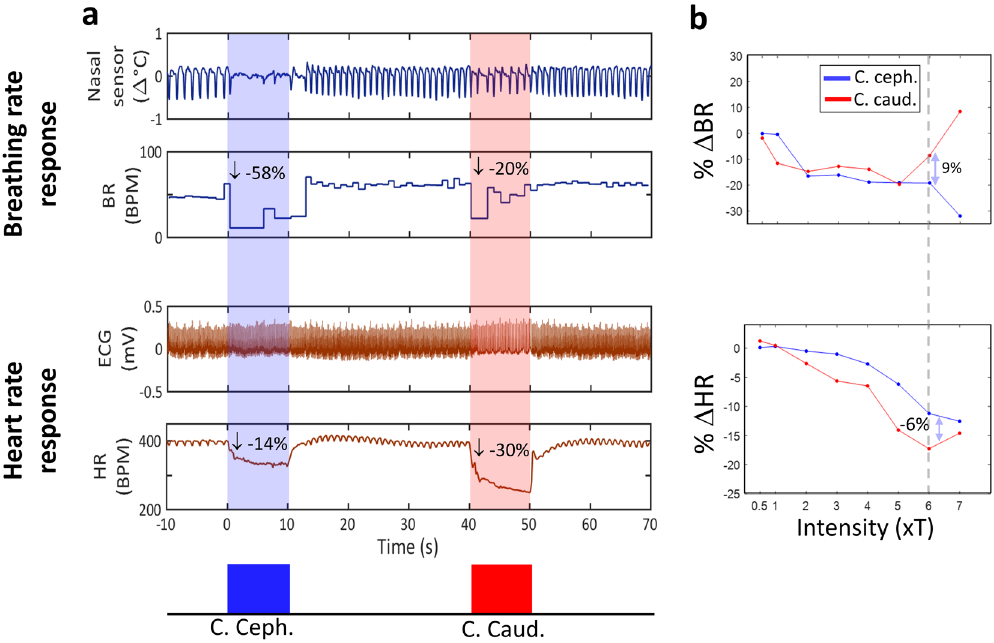
Figure 2. Afferent and efferent physiological responses to VNS of opposite polarities. ( a ) Afferent (breathing rate, BR) and efferent (heart rate, HR) responses to individual VNS trains of stimuli of 2 opposite polarities: cathode cephalad (blue trace), followed by cathode caudad (red trace). Cathode cephalad polarity was associated with a stronger afferent response ( − 58% change in BR and − 14% change in HR), whereas cathode caudad with a stronger efferent response ( − 20% change in BR and − 30% in HR). Stimulation parameters for both trains: 200 μ A, 500 μ s, 10 s-long train (300 pulses), 30 Hz. ( b ) Example of BR responses (top panel) and HR responses (bottom panel) to VNS of 2 opposite polarities, at a range of current intensities. Current intensity was normalized with respect to “physiological threshold” (T). In this case, cathode caudad polarity typically elicited greater drops in BR, whereas cathode cephalad greater drops in HR. Each of the 2 two-headed arrows denotes the difference in the corresponding physiological response between the 2 polarities at an intensity level of 6xT: response to cathode caudad minus response to cathode cephalad.